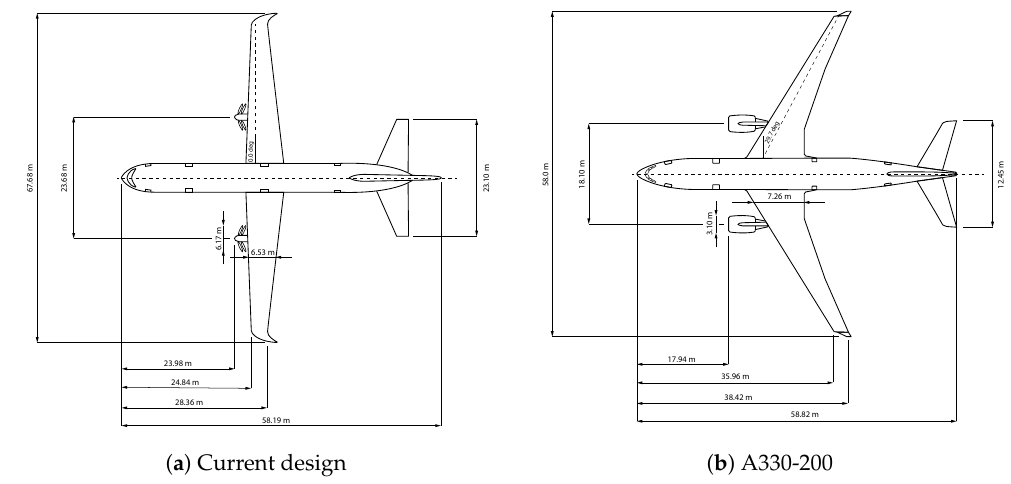
Figure 2. Airframe dimensions of current design and